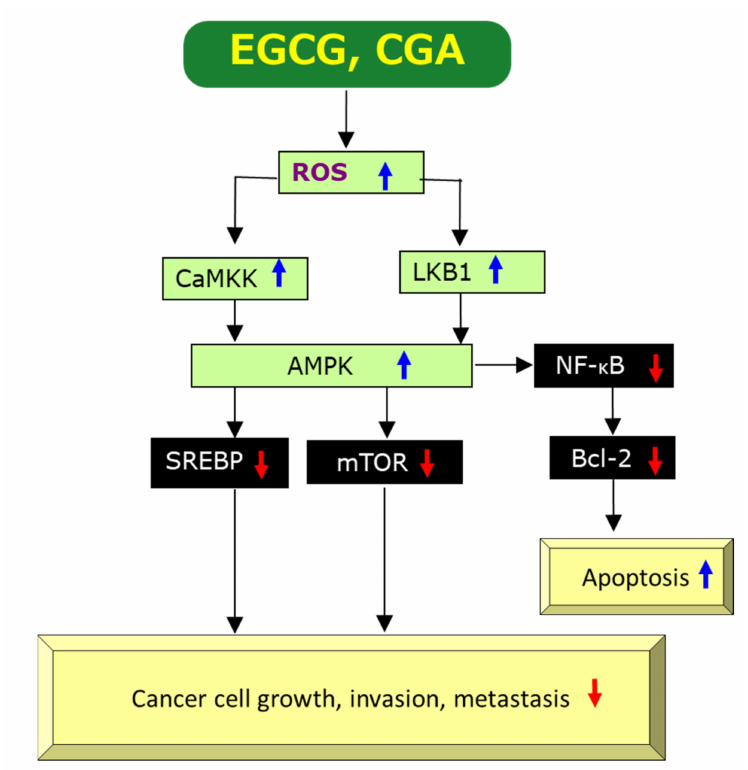
Figure 3. A possible mechanism by which EGCG and CGA exert anti-cancer e ff ects via generation / upregulation of ROS. Red ↓ and blue ↑ marks represent downregulation / suppression and upregulation / stimulation,